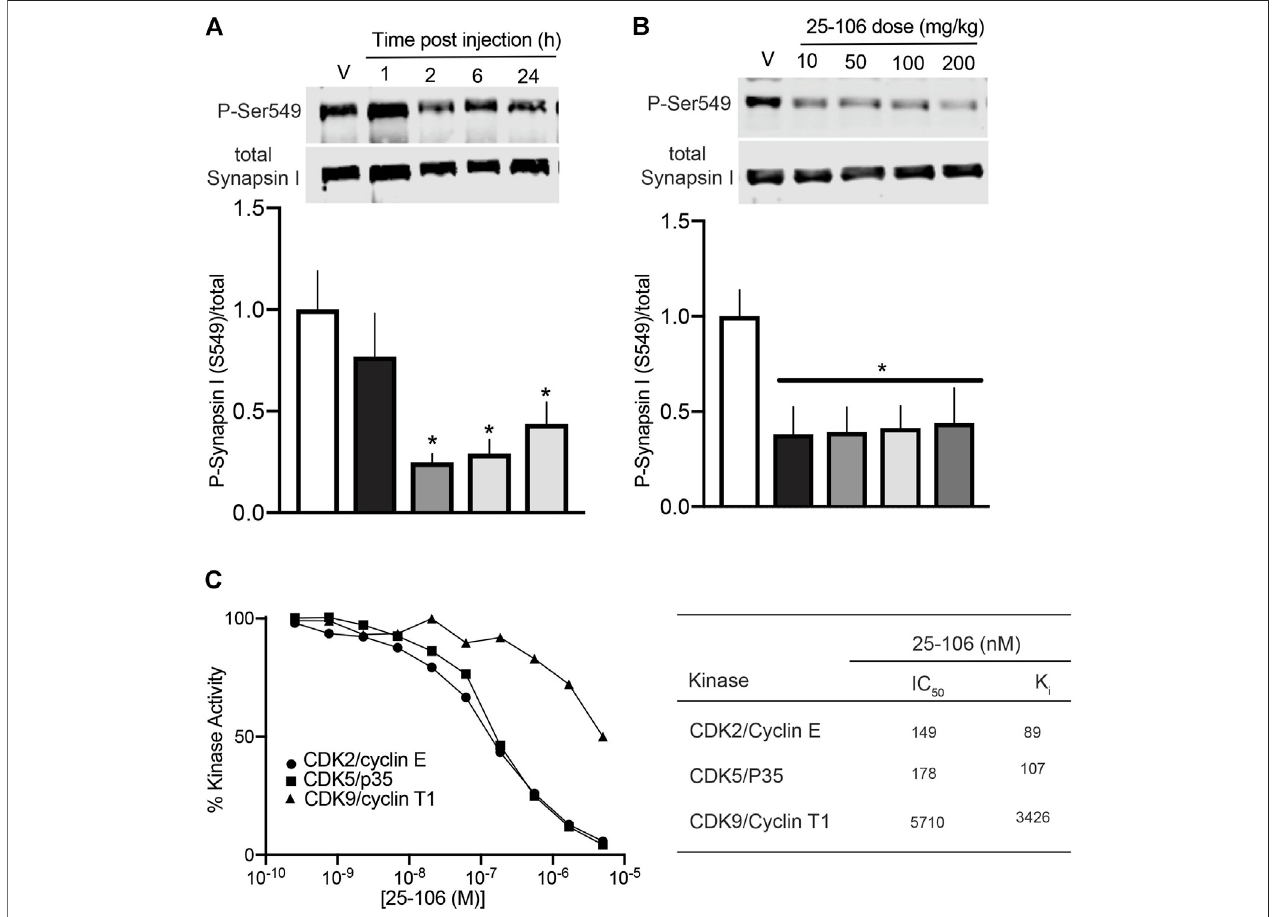
FIGURE 3 | In vivo ef fi cacy and in vitro speci fi city of 25 – 106 (A) . Quantitative immunoblot analysis of striatal brain lysates for phospho-Ser549 synapsin I after dosing 50 mg/kg 25 – 106 across the times indicated ( n = 4 per group) (B) . Quantitative immunoblot of phospho-Ser549 synapsin I 24 h post administration across doses indicated ( n = 4 per group). (C) . In vitro kinase assay (30 min) with Cdk2/Cyclin E, Cdk5/p25, and Cdk9/Cyclin T1 treated with 0 – 5 µM 25 – 106 (left) calculated IC 50, K i values of each kinase (right). * p < 0.05 student ’ s t